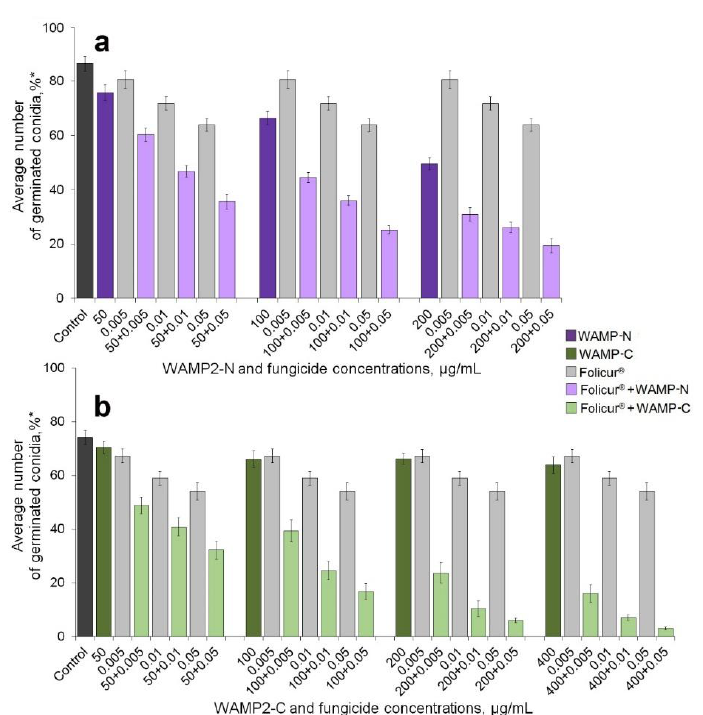
Figure 1. Inhibitory effect of Folicur ® EC 250 on the germination of Fusarium oxysporum microconidia exposed to ( a ) N-terminal (WAMP-N), ( b ) C-terminal (WAMP-C) fragments of a wheat hevein-like antimicrobial peptide WAMP-2, ( a , b ) Folicur ® , alone, and this fungicide in combination with ( a ) WAMP-N or ( b ) WAMP-C. * The average number of germinated conidia is expressed in percent relative to the total number of conidia counted in controls and treatments. Suspensions of conidia germinated in sterile distilled water (SDW) were used as controls. Columns represent the means calculated for three experiments (100 conidia in one replication of a treatment, 5 replications per treatment in each of three experiments); in total, 1500 conidia were examined per treatment. Experiments were carried out with independently synthesized WAMP-N and WAMP-C peptides on conidia sampled from three plates with the pathogen colonies grown independently for each of the experiments. Y-bars indicate standard deviations (SD). Significance of differences of means between treatments and controls at p ≤ 0.05 was determined using a t -test for independent variables (STATISTICA v. 6.1, StatSoft Inc.). For each concentration combination, Ee values calculated by Limpel’s formula (see Material and Methods, 4.7), and observed Er values are presented in Table 2.